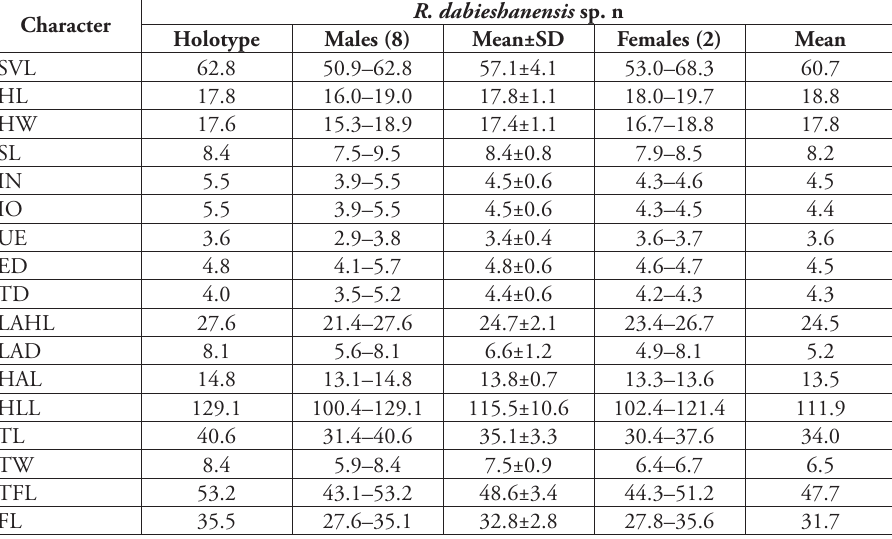
Table 4. Measurements [in mm; mean±SD (range)] of adult specimens of Rana dabieshanensis sp. n.